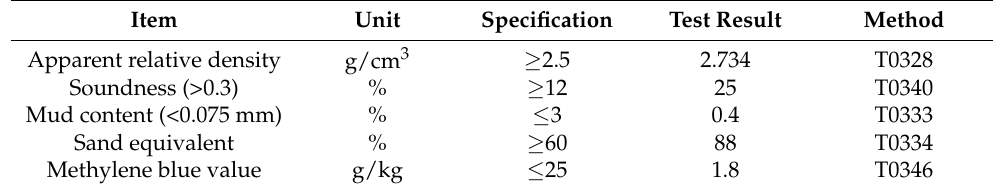
Table 4. Technical indices of fine aggregate.